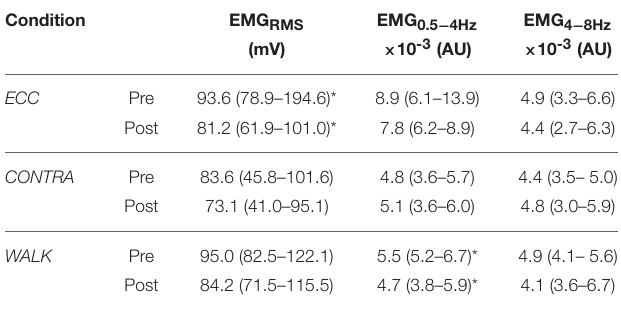
TABLE 3 | Summary of EMG variables for